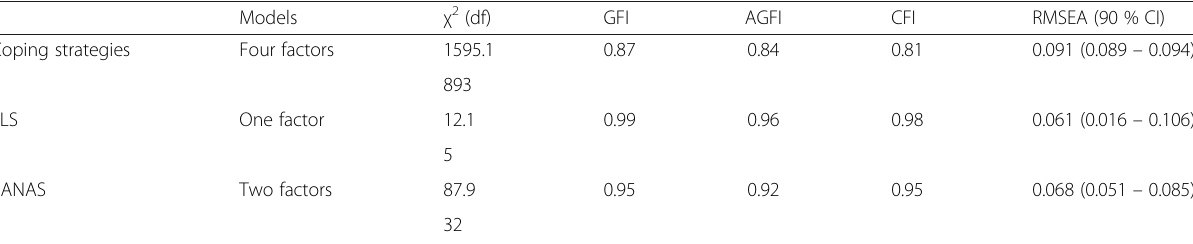
Table 1 Indicators of adjustment of coping strategies measure, SLS and PANAS Scales